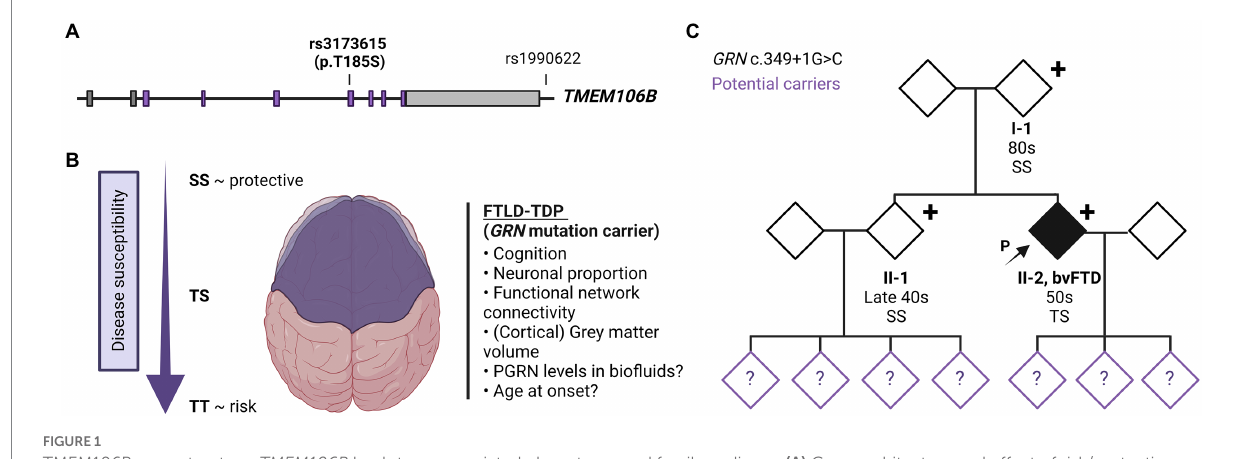
FIGURE 1 TMEM106B gene structure, TMEM106B haplotype-associated phenotypes and family pedigree. (A) Gene architecture and effect of risk/protective haplotype of TMEM106B . The TMEM106B gene is comprised of nine exons, coding regions are labeled in purple. The major SNPs associated with neurodegenerative diseases are indicated with sentinel SNP (rs1990622), located in the regulatory sequence downstream of TMEM106B , and coding variant rs3173615 (c.554C > G, p.Thr185Ser). (B) Current understanding of the effect of TMEM106B haplotype on brain health and disease susceptibility in FTLD- GRN . (C) Family pedigree. Patient II-2 presented in the clinic in their 50s with symptoms of bvFTD. Genetic testing revealed a disease-causing variant in GRN (c.349 + 1G > C, Splice donor). The patient’s asymptomatic parent (I-1) and younger sibling (II-1) who also carry the mutation were evaluated in their 80s and late 40s, respectively. TMEM106B genotyping showed I-1 and II-1 to have two copies of the protective TMEM106B allele (SS), while the patient is heterozygous (TS). The children of II-1 and II-2, were not genetically tested but are at risk of carrying the mutation, as represented with a question mark within the symbol. Figure was created using